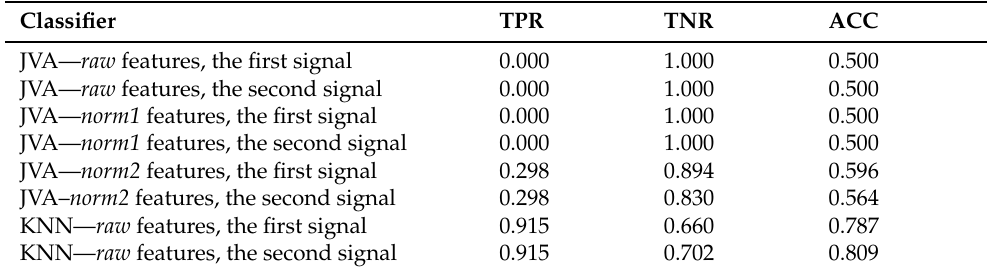
Table 2. Classification comparison for different normalizations. TPR, true-positive rate; TNR, true- negative rate; ACC,